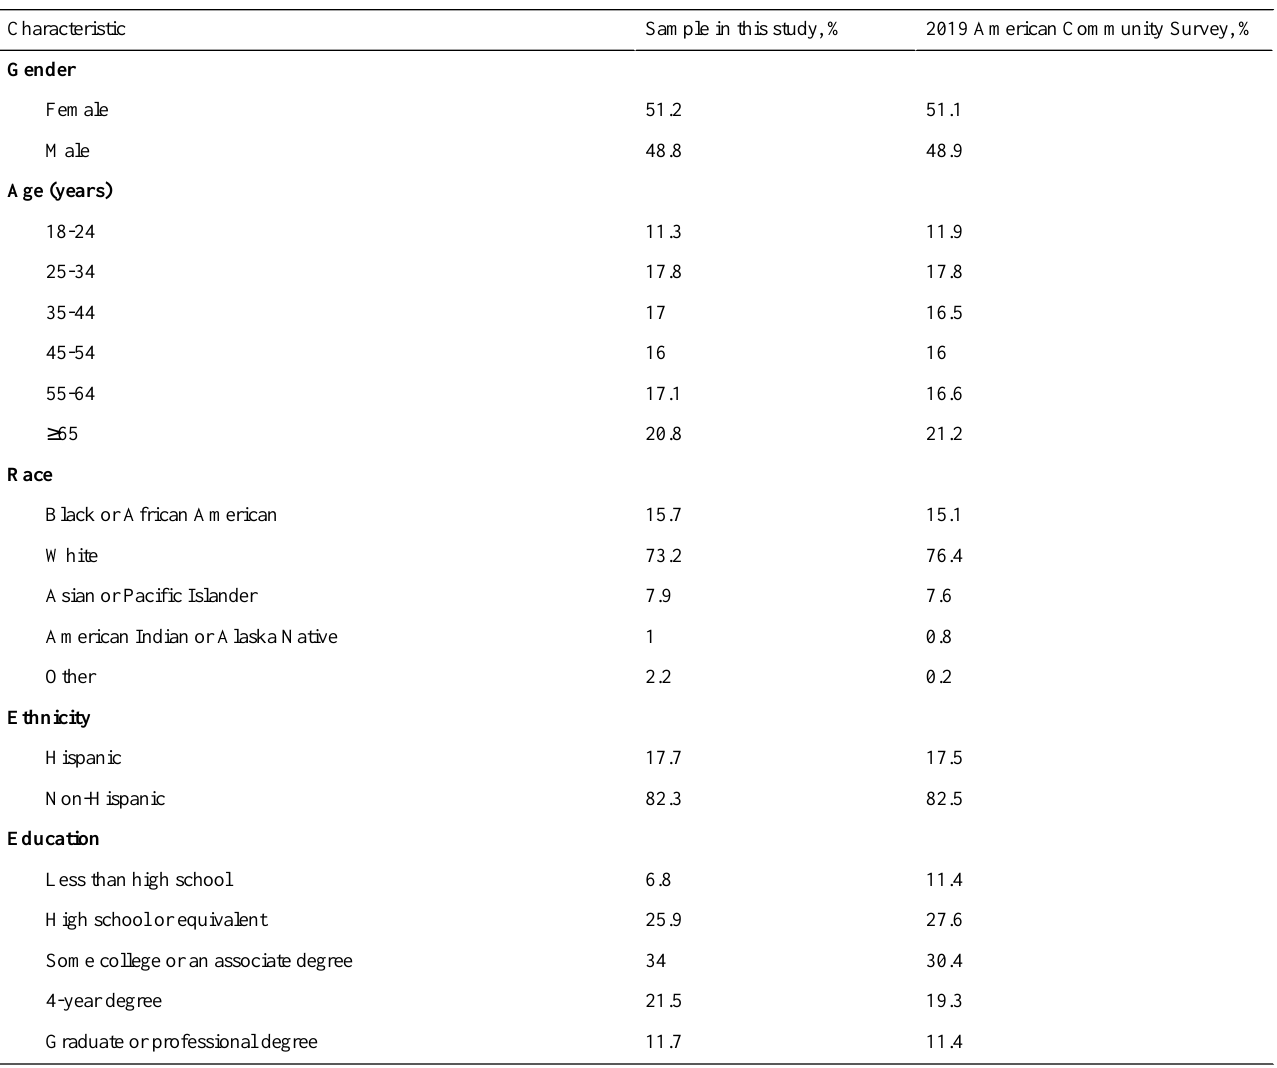
Table 1. Sample comparison. a